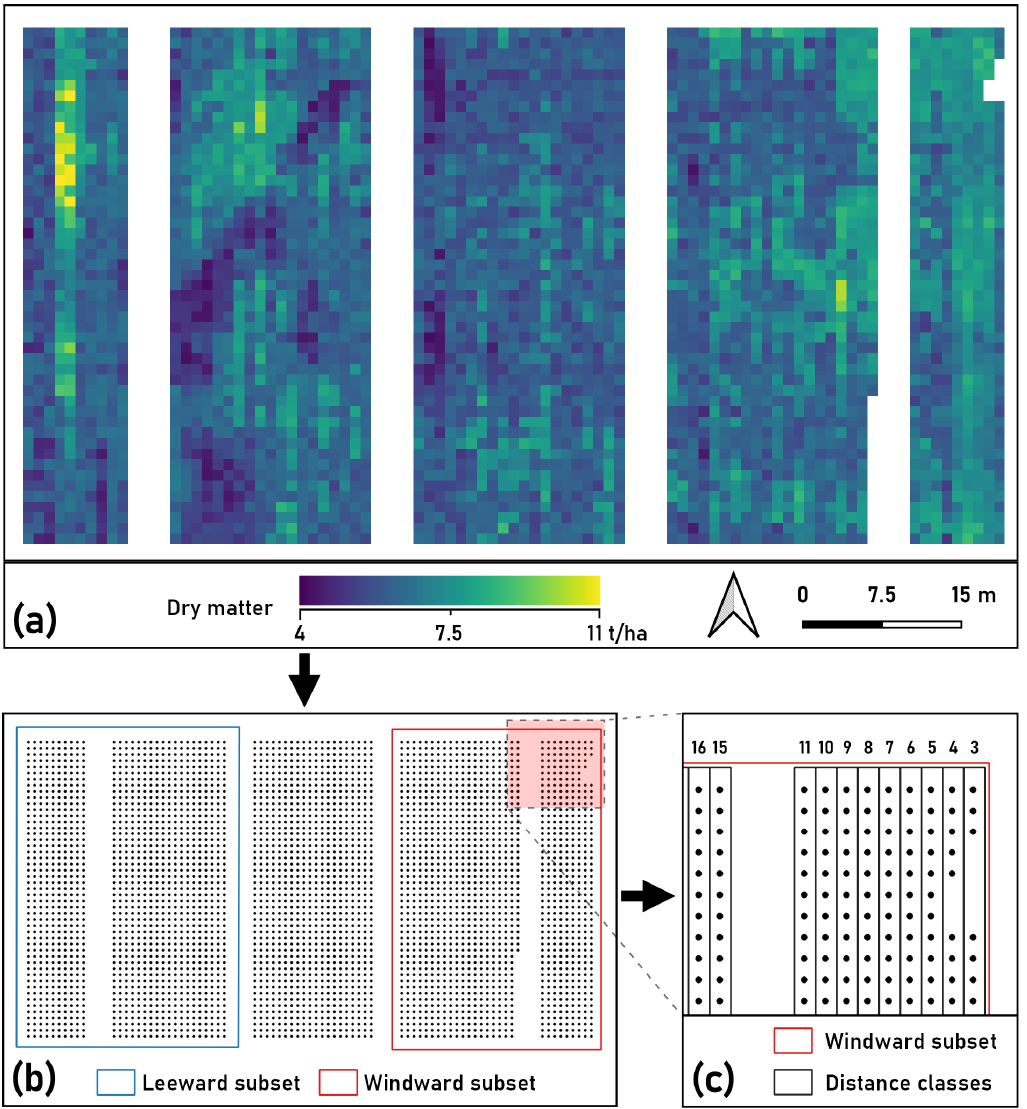
Figure 3. Generation of point data from predicted raster data. ( a ) Predicted DM at AFS site Forst. Spatial resolution is 1 m. ( b ) Generated point values and subsets from the raster. ( c ) Distribution of 1 m wide distance classes (real distance to tree row).